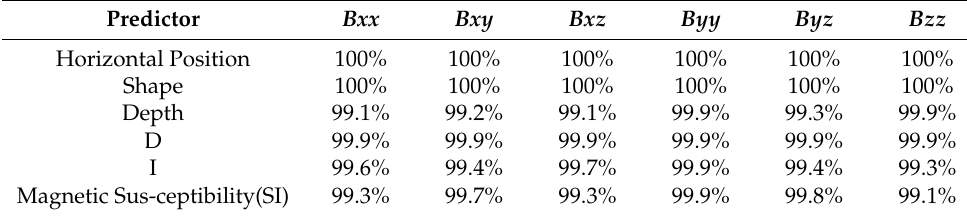
Table 3. Model prediction accuracies of Rectangle_2B.